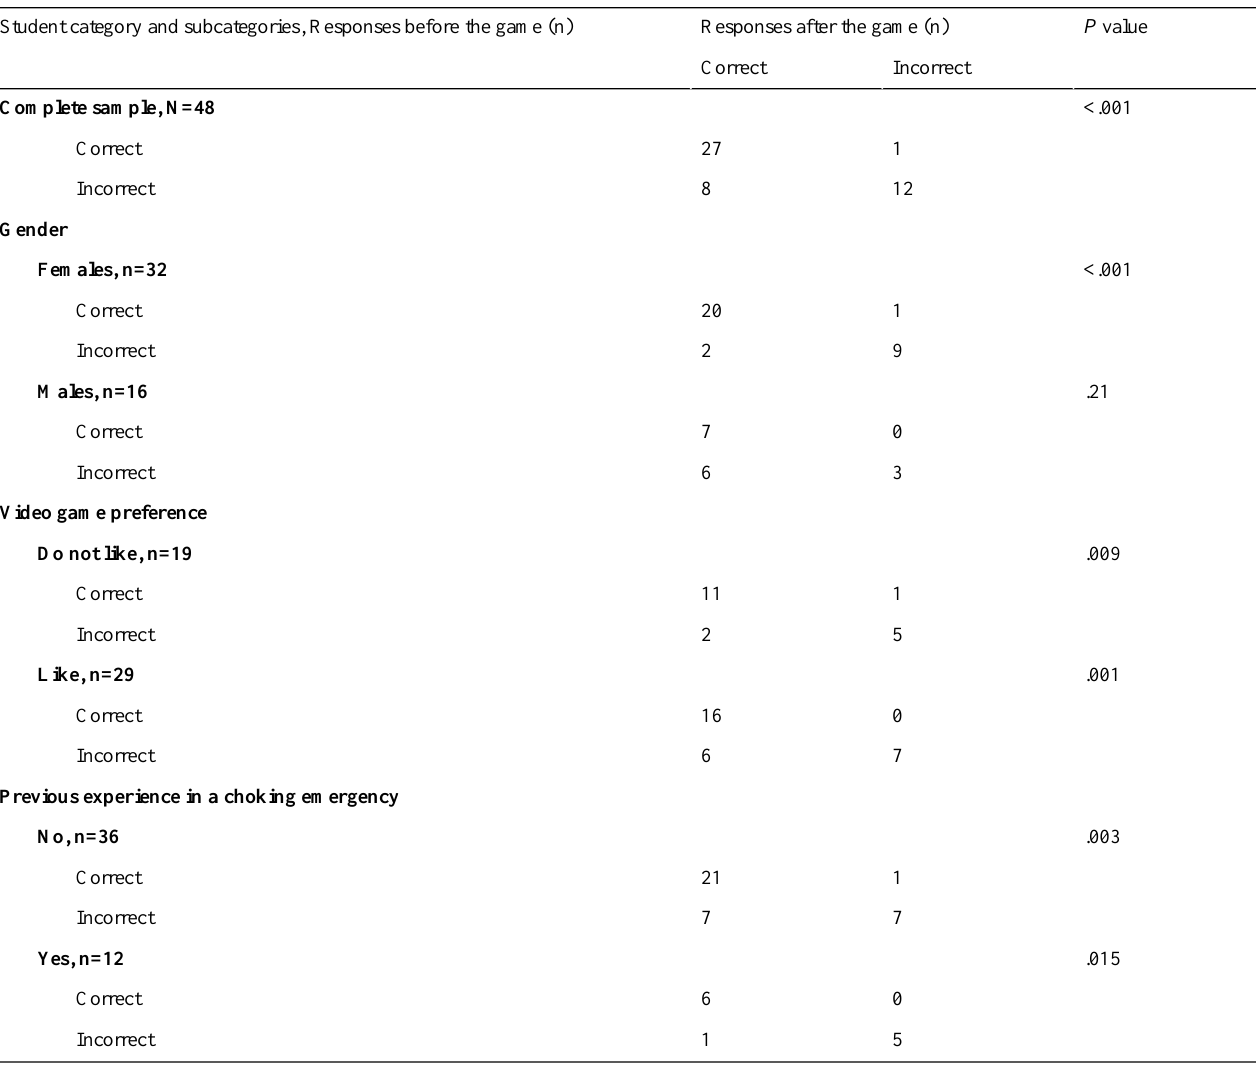
Table 7. Statistical analysis of the responses regarding the resuscitation protocol before and after playing the game.